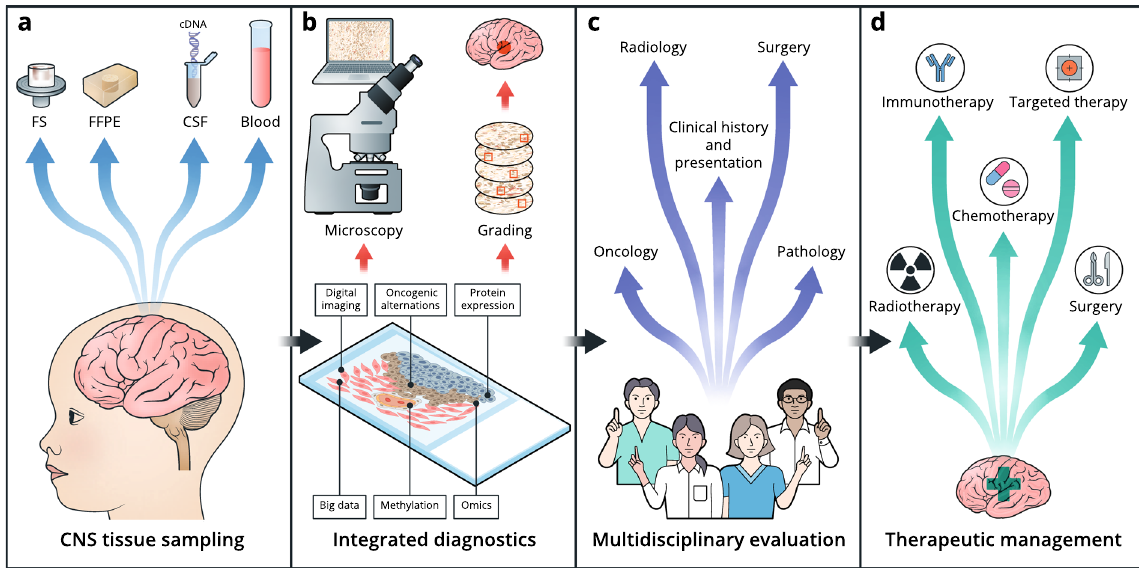
Fig. 1 Multistep process for an integrated diagnostic and therapeutic work fl ow in pediatric neuro-oncology. a Obtaining diagnostic samples. b Appliying modern diagnostic platforms. c Integrated diagnostic in treatment decsions. d Using modern